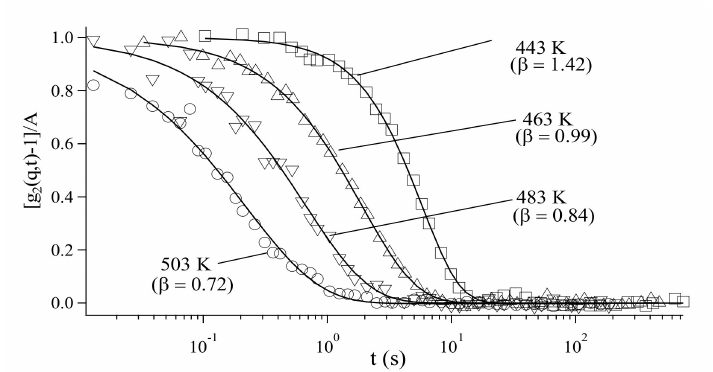
Figure 11. Representative results of normalized time-autocorrelation functions at q = 2.15 × 10 − 2 nm − 1 of the scattered speckle intensity from PS-grafted NPs in a PS matrix of sample-A at di ff erent temperatures. The solid lines are the fitted curves by stretched exponential function. Reproduced from [55], with permission from the American Physical